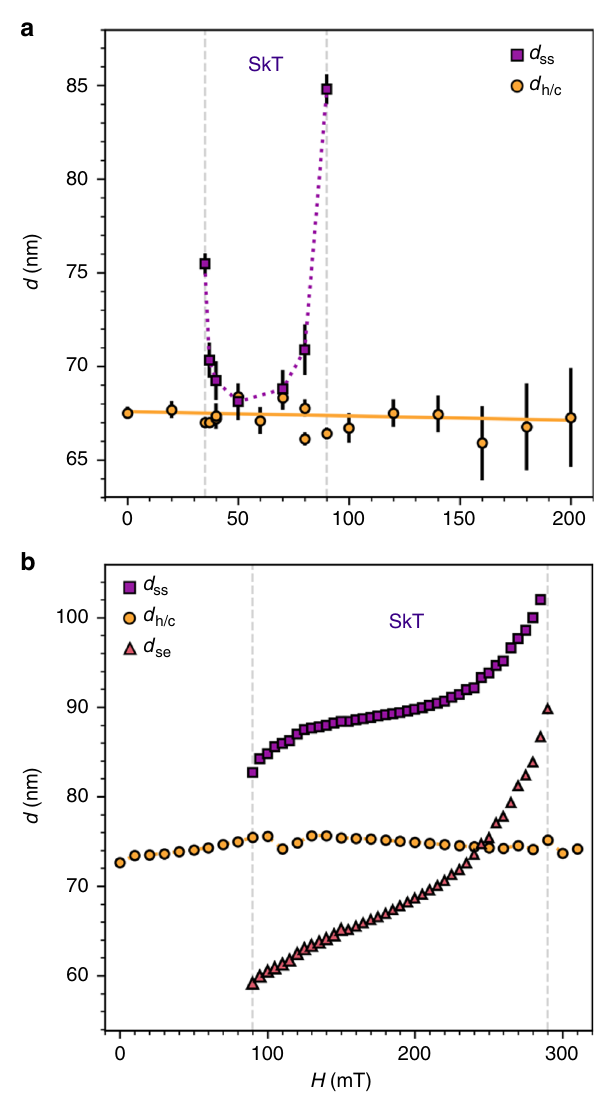
Fig. 5 Spacing of the skyrmion tube state. a , b The skyrmion-skyrmion tube spacing, d ss , the skyrmion-edge distance d se , and helical/conical state period, d h ∕ c , plotted as a function of applied magnetic fi eld for the experimental and simulated images respectively. Error bars on the experimental data indicate the standard deviation obtained when fi tting line pro fi les of the magnetic contrast from the STXM images with a sine simulated data, and are plotted as a function of applied magnetic fi eld in Fig. 5a, b, respectively. The skyrmion-edge distance d the simulated data is also plotted. In both the simulation and experiment, d h,c was found to remain approximately constant across the full range of applied magnetic fi eld. In contrast, the simulated d ss and d se increase with applied magnetic fi eld, exhi- biting skyrmion-skyrmion and skyrmion-edge interactions, which are attractive at low fi elds, and repulsive at higher fi elds (see Supplementary Fig. 12 and Supplementary Note 9 for details), in agreement with studies of such interactions for the out-of-plane SkL state 38,39 . At low and high fi elds, d ss becomes, respectively, smaller and larger than the skyrmion radius. In both instances, the magnetisation of the SkT spin texture necessarily distorts, in a manner functionally similar to the distortion of the helical state into a chiral soliton lattice 40 (see Supplementary Fig. 13 and Supplementary Note 10).